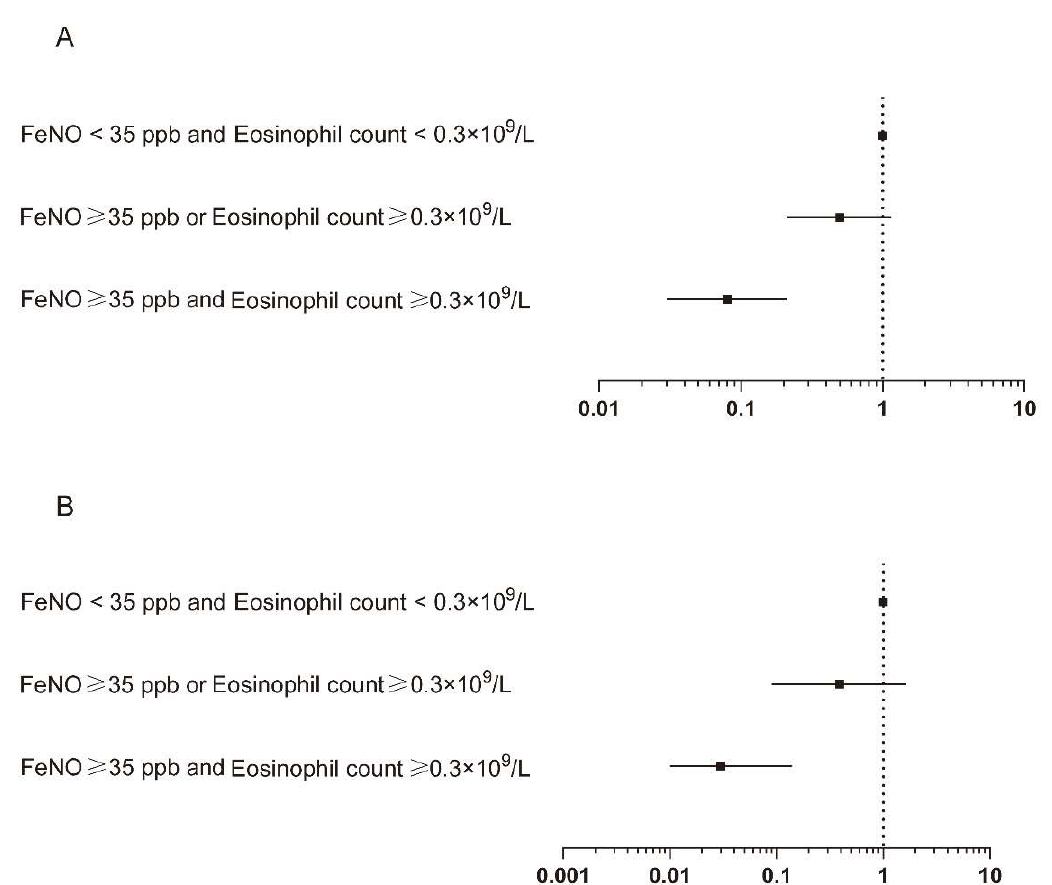
Figure 4. Combined association of increased FeNO level and blood eosinophil count with incidence of acute exacerbation of COPD: ( A ) Smoking status adjusted; ( B ) multivariable adjusted. Logistic regression models were used. Multivariable adjustment included age, gender, BMI, smoking status, FEV 1 post-BD% pred, SGRQ, and 6-minute walking distance. FeNO, exhaled nitric oxide fraction; BMI, body mass index; FEV 1 , forced expiratory volume in 1 s; BD, bronchodilator; SGRQ, St. George’s Respiratory Questionnaire.